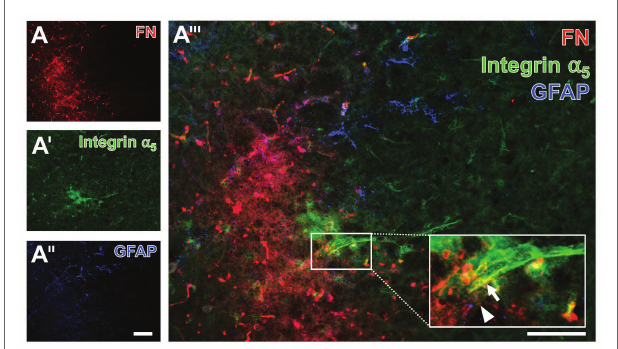
FIGURE 11 | Immunofluorescence labeling of fibronectin and associated integrin α 5 combined with the detection of astroglia in a mouse suffering from 72 h of experimental focal cerebral ischemia. Triple immunofluorescence labeling of fibronectin (FN, A ), integrin α 5 (A ' ) , and astroglia as identified by GFAP (A '' ) confirms the increased immunosignal of FN in the ischemia- affected striatum in an expanded time window of 3 days after ischemia onset. The immunosignal of GFAP-positive astrocytes is clearly diminished in the area of ischemia (A '' ) . FN and integrin α 5 appear vessel-associated, which becomes even clearer at a higher magnification (integrin α 5 : arrow in A ''' , FN: arrowhead in A ''' ). Scale bars: in A ''' = 100 μ m, in A '' (also valid for A and A ' ) = 100 μ